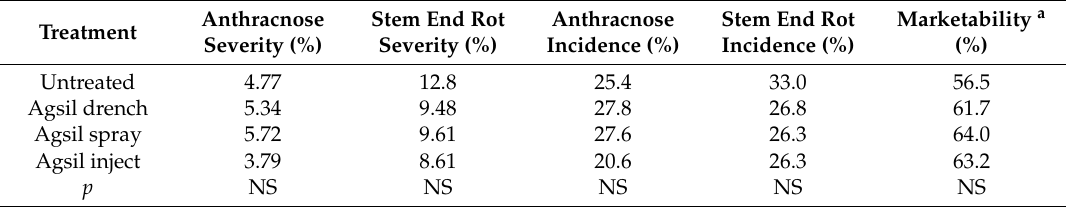
Table 5. Postharvest quality data collected from fruit harvested in August 2016 from Agsil amendment trial—Site 3,